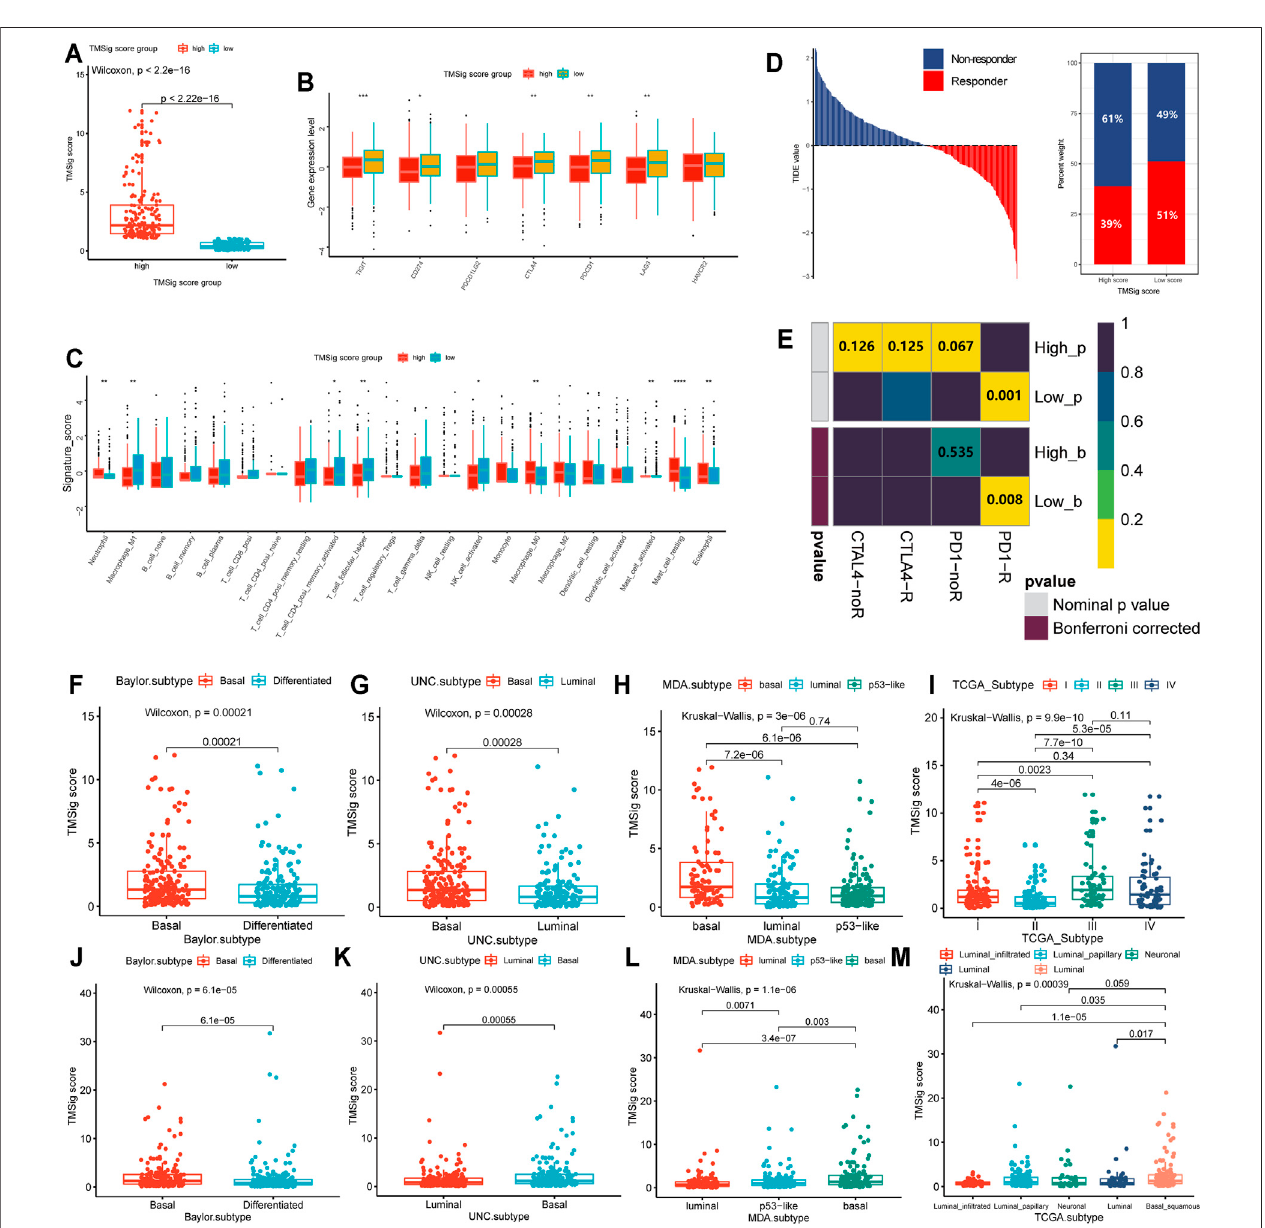
FIGURE5| Moleculardifferencesbetweenhigh-andlow-scoresubgroupsanddistributionamongprevioussubtypes. (A) TheTMSigscoreinthehighscoregroup was signi fi cantly higher than that in the low score group. (B) The expression level of immune checkpoints in the high score and low score groups. (C) Immune in fi ltration cells are expressed in the high score and low score groups (* p < 0.05, ** p < 0.01, *** p < 0.001, **** p < 0.0001). (D) The immune therapy response and TIDE value of patients with urothelial cancer. (E) The subclass mapping analysis showed a signi fi cant difference in response to anti-PD-1 therapy among these two groups. The distributionofTMSigscoreoftheIMvigor210cohortinmolecularsubtypes. (F) Baylorsubtype, (G) UNCsubtype, (H) MDAsubtype, (I) TCGAsubtypes.Thedistribution of TMSig score of the TCGA cohort in molecular subtypes. (J) Baylor subtype, (K) UNC subtype, (L) MDA subtype, (M) TCGA subtypes.